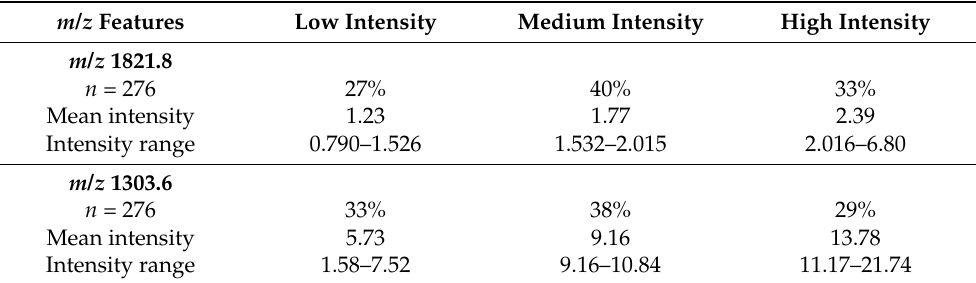
Table 3. Overview of clustered mean intensities with PAM of m / z 1821.8 and m / z 1303.6. m / z Features Low